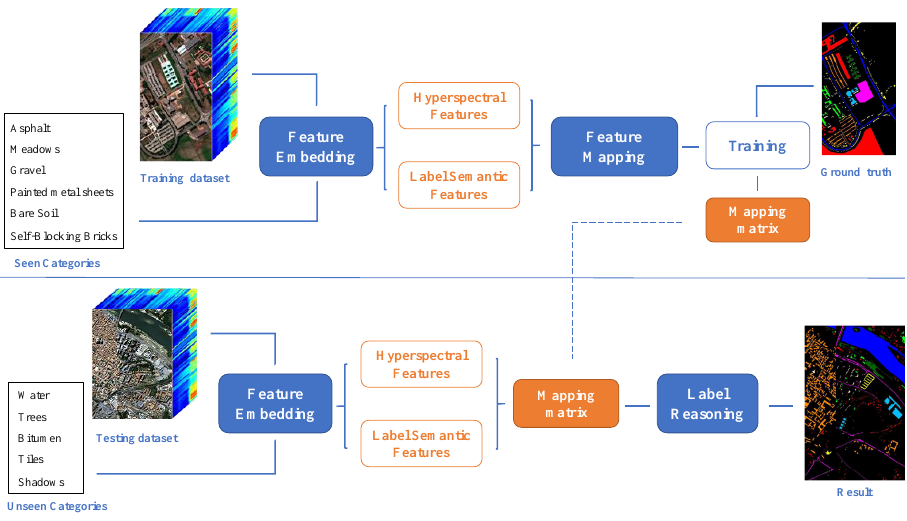
Figure 4. Illustration of the whole scheme. In the training process, through feature embedding, the training data and the label of categories are embedded into the corresponding feature spaces to obtain hyperspectral features and label semantic features respectively. Then, a mapping matrix representing the correspondences between these features is learned by feature mapping. In the testing process, the learned mapping is transferred to the hyperspectral features and label semantic features of the testing data. At last, we derive the final label by label